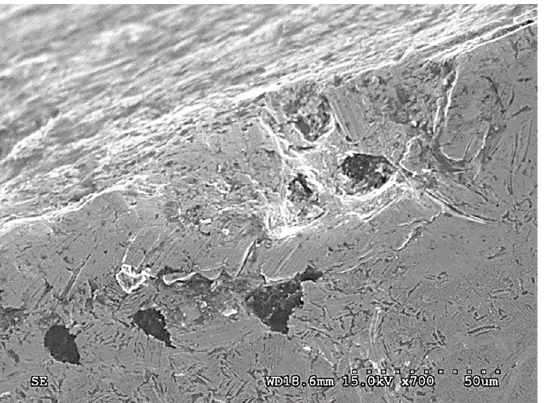
Figure 10. Chippings in the layer running along the boundaries of graphite nodules (ADI_240_D) (SEM; cross-section).